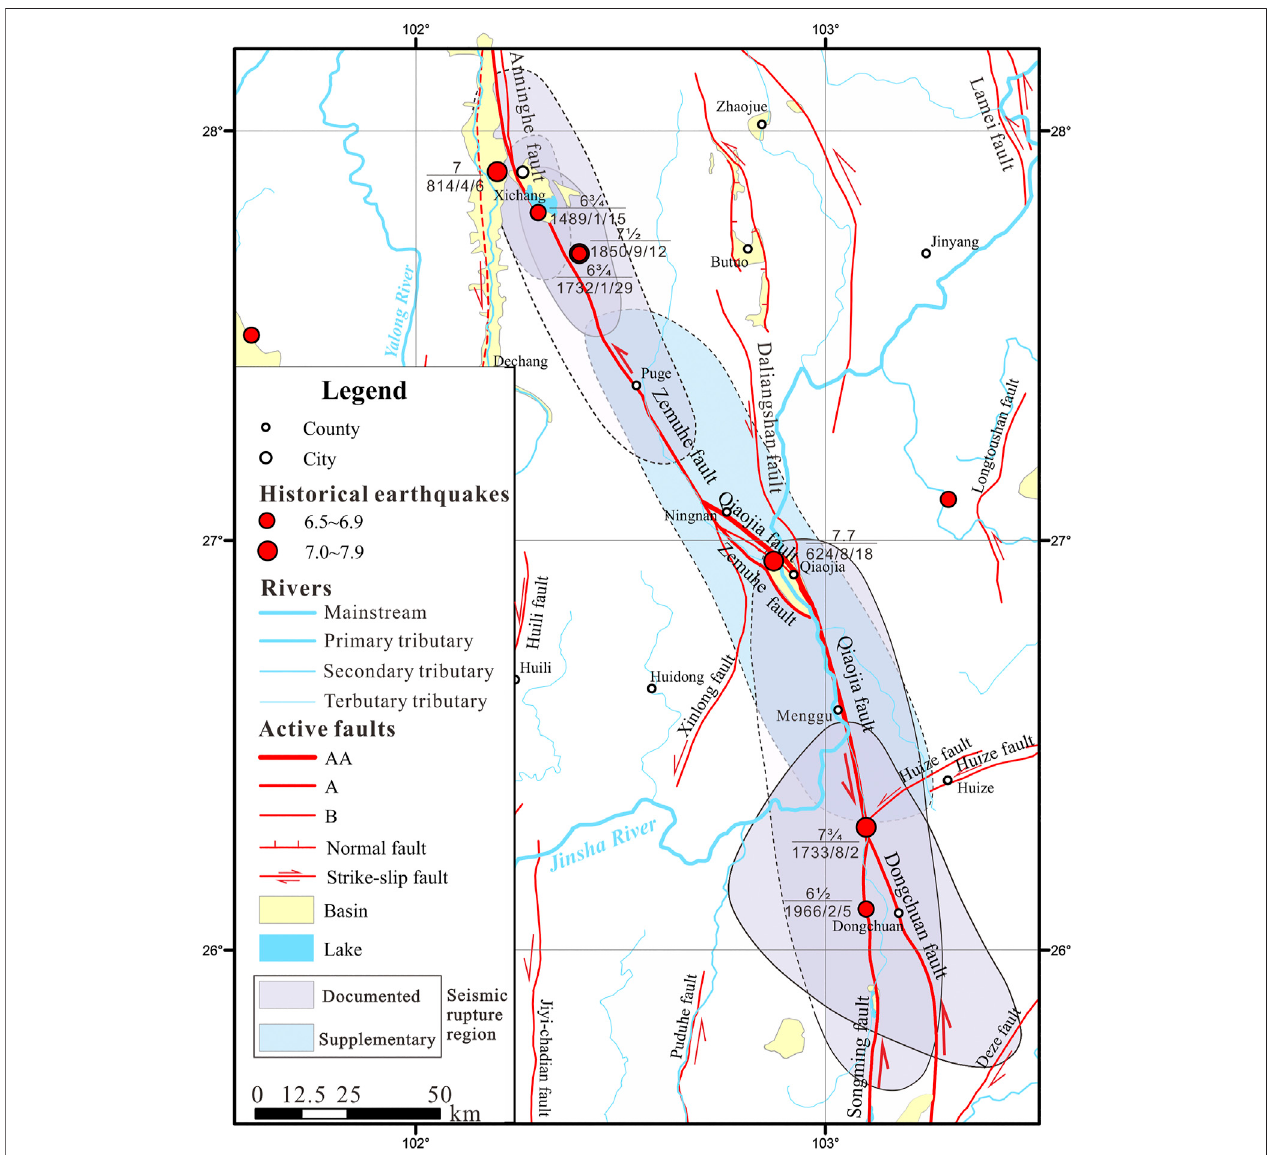
FIGURE 13 | Rupture areas with intensity ≥ Ⅸ for the historical earthquakes from Xichang to Dongchuan. The dashed circle indicates the area not veri fi ed in the fi eld. For the active faults, AA, A, and B indicate their activity of extremely strong, strong, and medium.